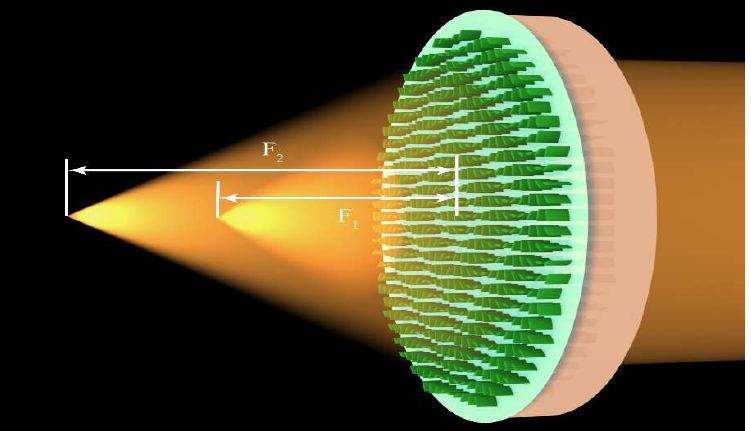
Figure 1. Schematic of the electrically modulated bifocal metalens. The metalens can focus at two different focal points at the same time. By applying different voltages, the intensity ratio of the two focal points